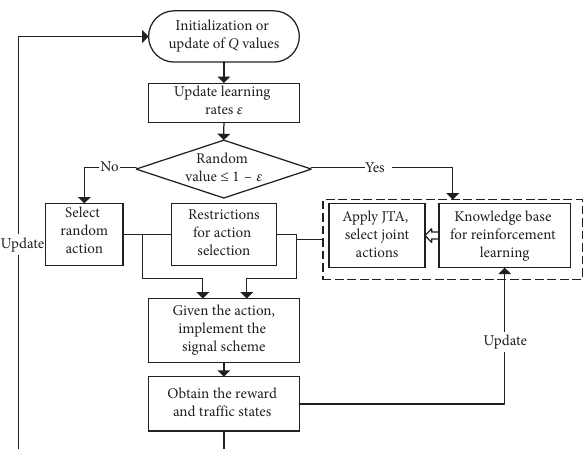
Figure 2: The control flow of the JTA-based RL algorithm